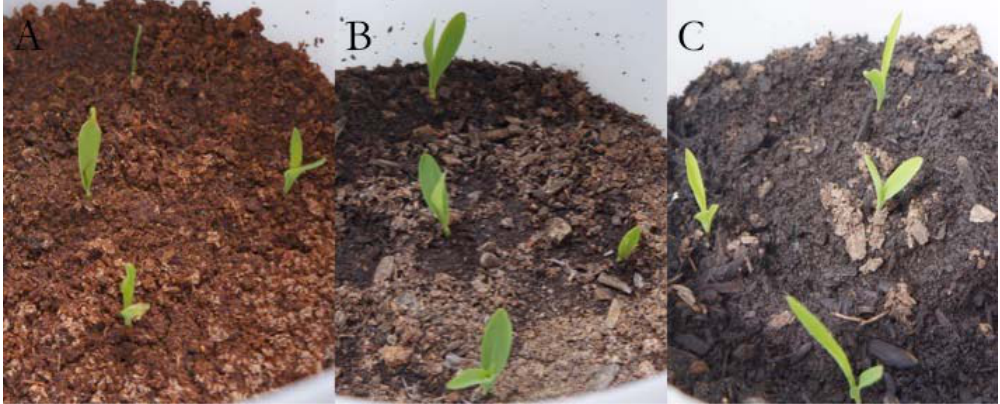
Figure 2. Corn plants at Day 2 post ‐ emergence in ( A ) 100% depleted marc, ( B ) 50:50 depleted marc/compost, and ( C ) 100% compost.